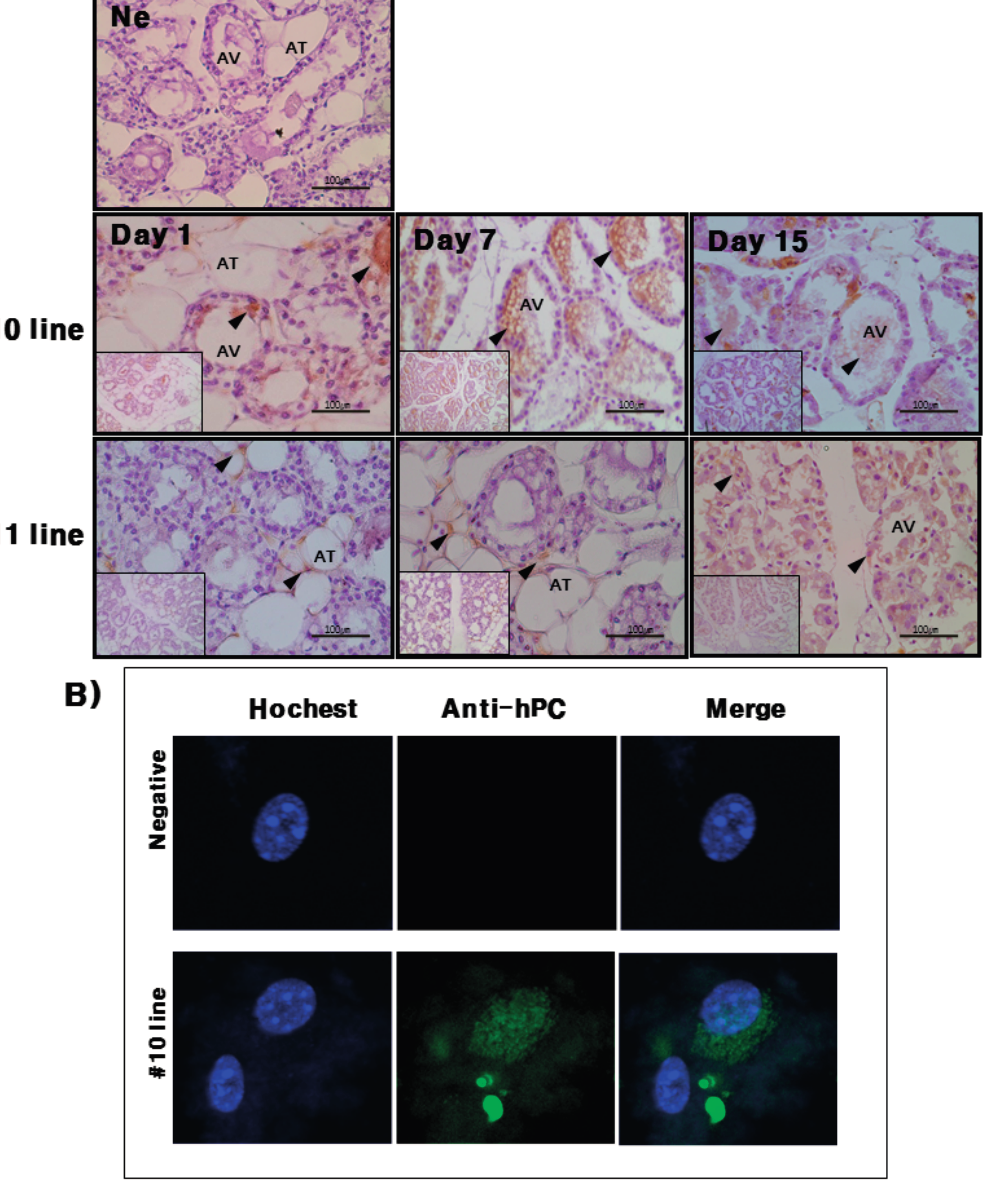
Figure 5. Localization of hPC protein expressed in the mammary glands during lactation by immunohistochemistry and in the cultured Tg mice mammary gland cells by immunofluorescence. ( A ) Immunohistochemistry. Representative immunohistochemical analyses using hPC antiserum (1:1000) and swine anti-rabbit secondary antibodies (1:1000). Preimmune serum (1:1000) was used for primary antiserum as the negative control. Mammary gland sections are shown on days 1, 7, and 15 during lactation. Black bar = 100 μ m. Arrows indicate alveolar epithelial cells of the mammary gland; ( B ) Immunofluorescence in cultured mammary glands of Tg mice (#10 line) on day 7 during lactation. Counter staining was performed with DAPI (blue). hPC expression was detected by Alexa 488 (green). The merged picture shows blue and green